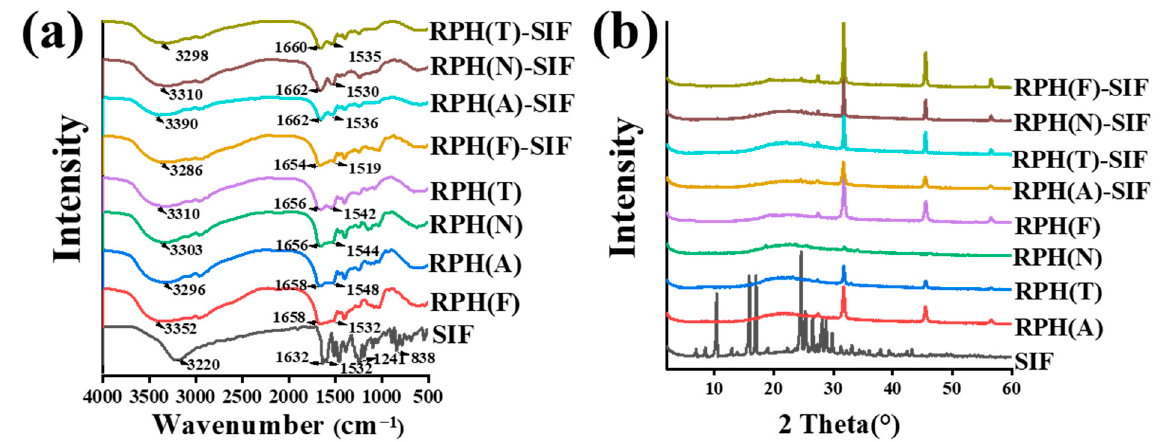
Figure 4. Fourier transform infrared spectra ( a ) and X-ray diffraction (XRD) patterns ( b ) of SIF, RPH, and RPH-SIF complex nanoparticles.